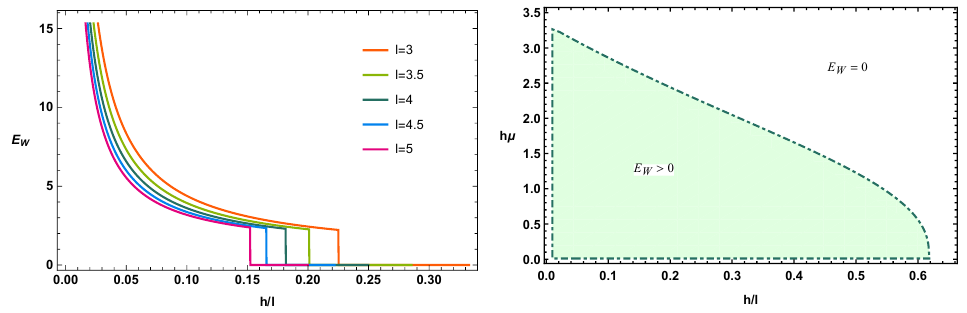
Figure 3 . Left : E W in Extremal AdS black brane as a function of h=‘ for di(cid:11)erent values of ‘ . Right : parameter space for d = 3 where E W is nonzero only in the shaded region. Here we have set r h =